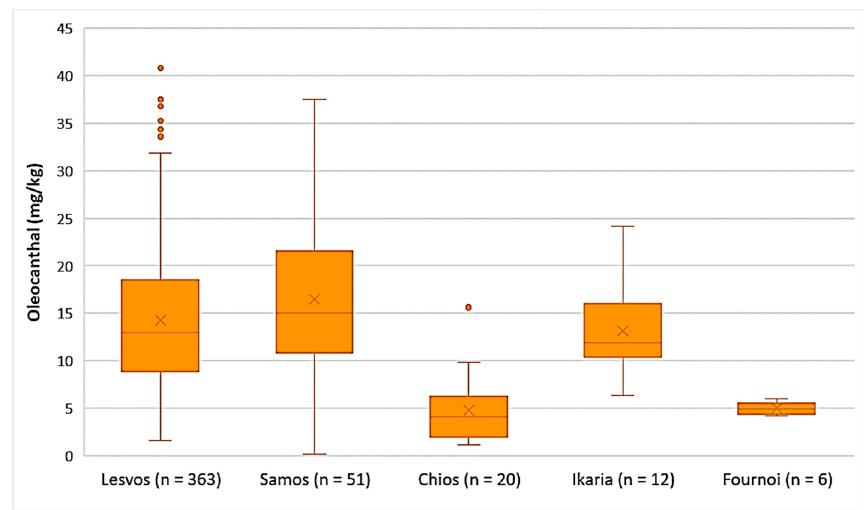
Figure 7. Concentration of oleocanthal (mg/kg) in EVOOs from the islands of Lesvos, Samos, Chios, Ikaria, and Fournoi.